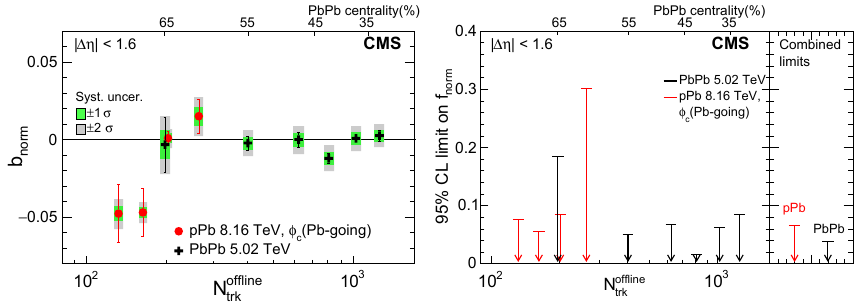
Figure 6. Extracted intercept parameter b norm (left) and corresponding upper limit of the fraction of v 2 - independent γ 112 correlator component (right), averaged over = 8 . 16 TeV and PbPb collisions at 5.02 TeV [14]. Statistical and systematic uncertainties are indicated at √ s NN by the error bars and shaded regions in the top panel,